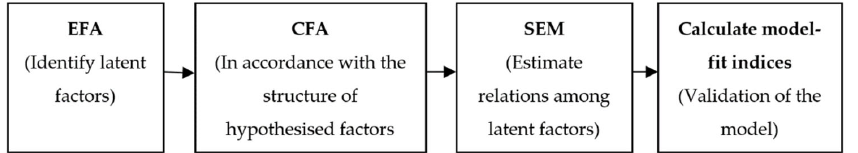
Figure 2. SEM modelling design. Note : EFA: Exploratory Factor Analysis; CFA: Confirmatory Factor Analysis; SEM: Structural Equation Modelling.